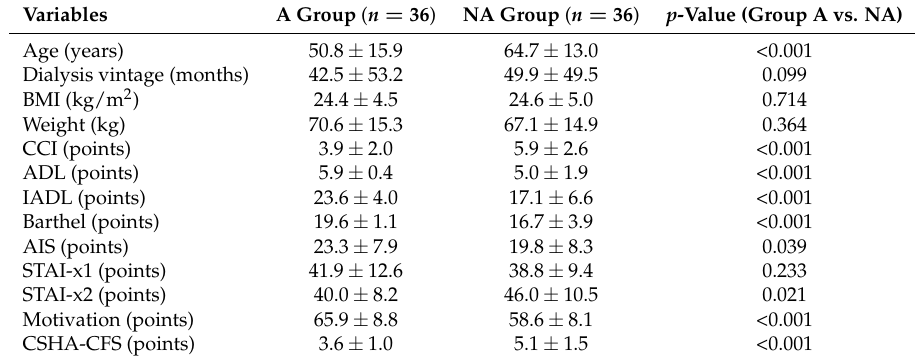
Table 3. Results for factors associated with adherence to physical activity recommendations ( n =